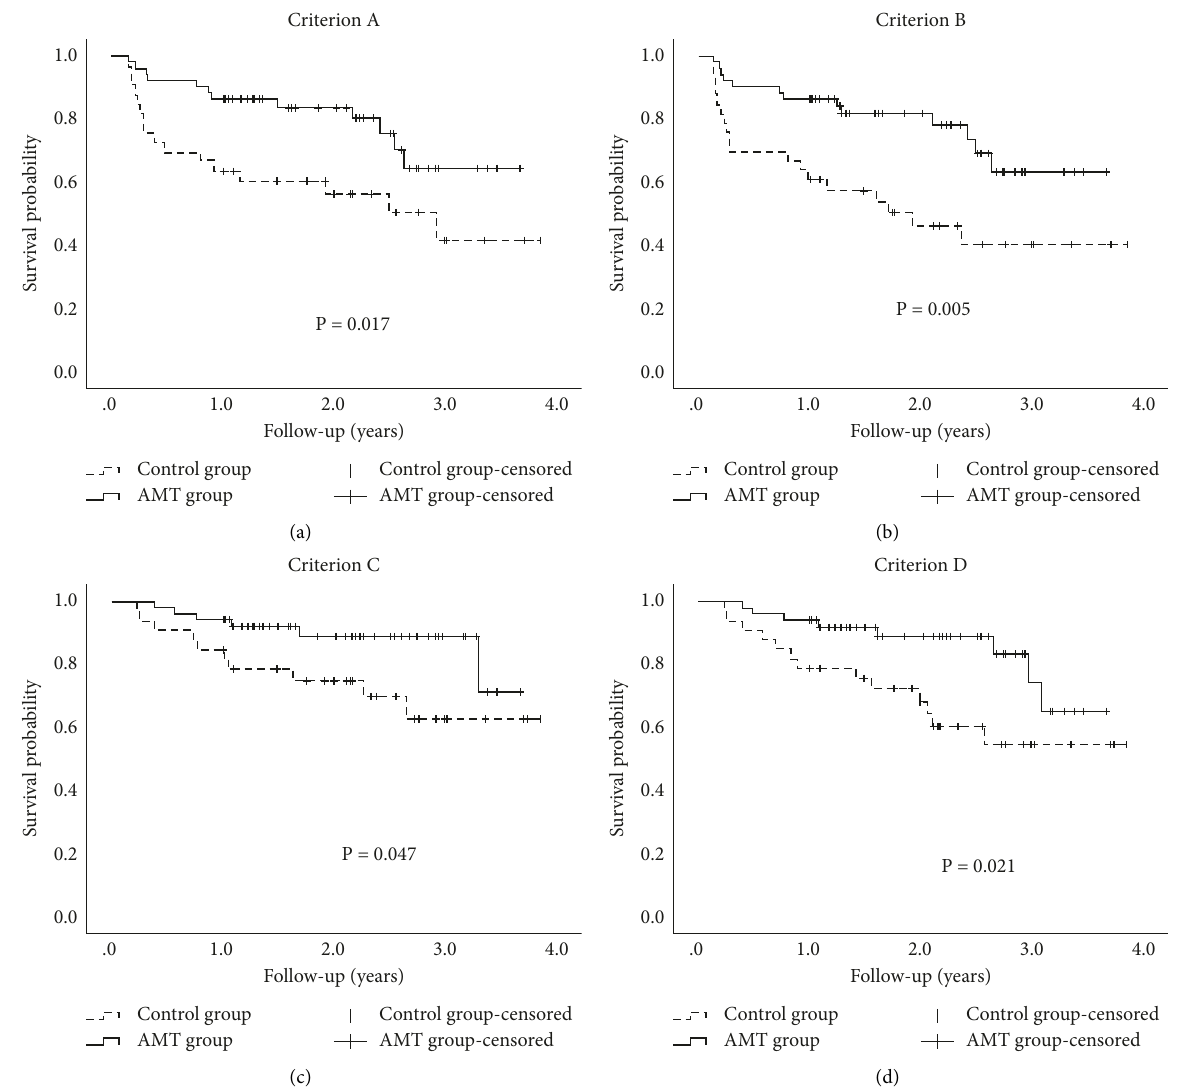
Figure 2: Cumulative probabilities of surgical success after trabeculectomy in the amniotic membrane transplantation (AMT) and control groups. Surgical success rates of the AMT group were significantly higher than those of the control group for all criteria (all p s